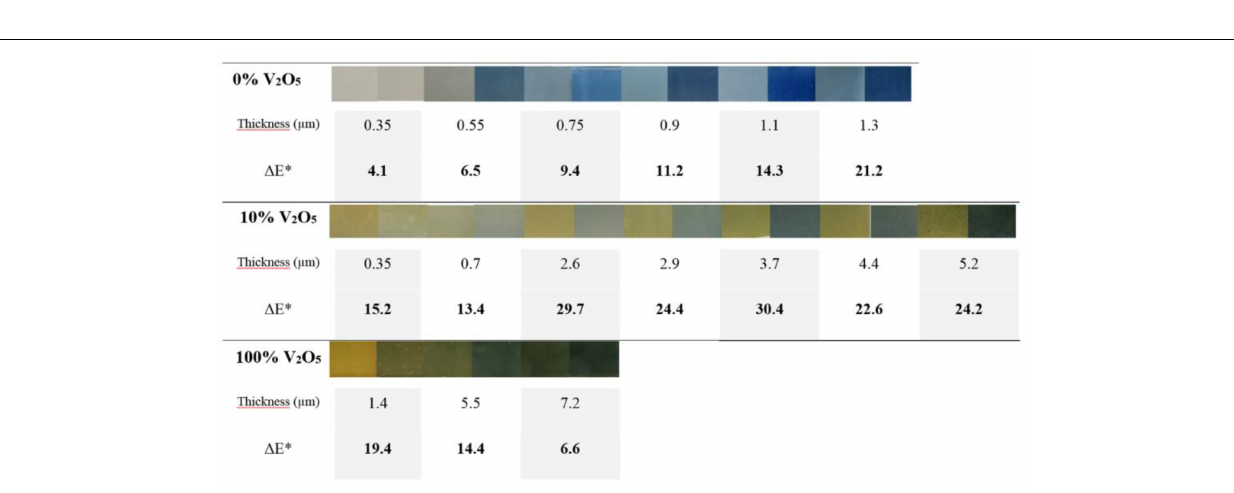
Frontiers in Materials |